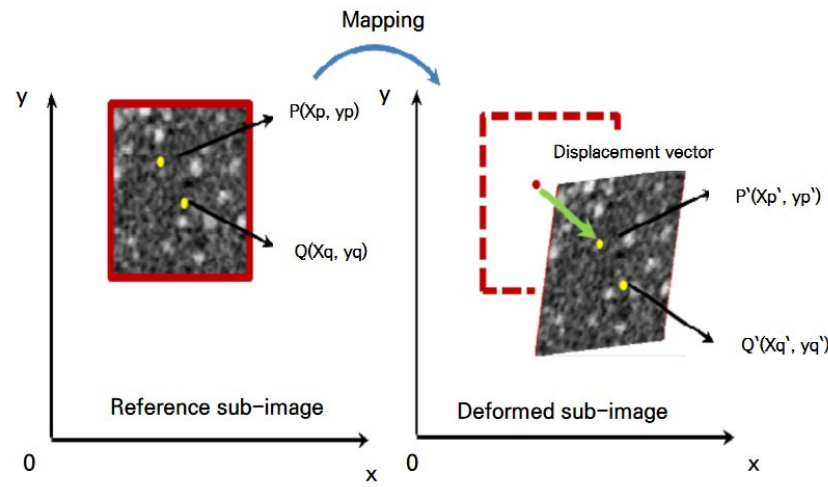
Figure 5. Schematic diagram for correlating the images of a reference subset before deformation and a target (or deformed) subset after deformation.